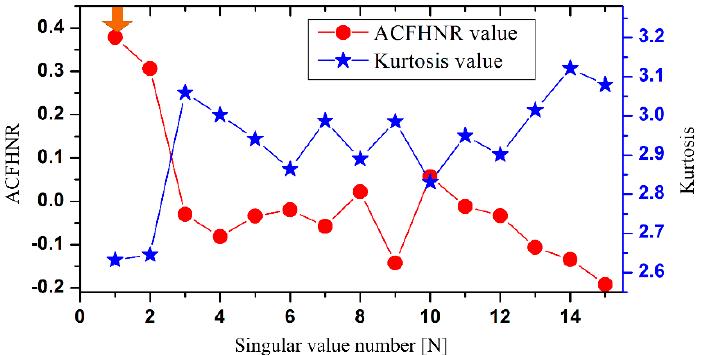
Figure 14. The comparison of the proposed ACFHNR index and the kurtosis.